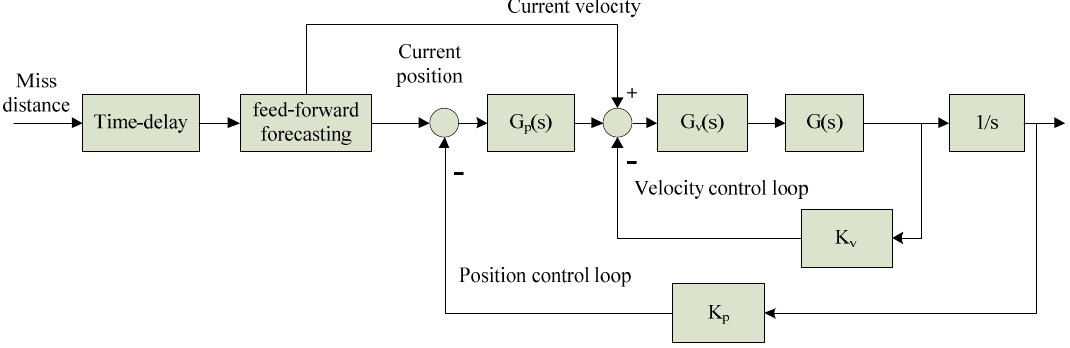
Figure 6. Diagram of feed-forward forecasting controller in opto-electronic platform.